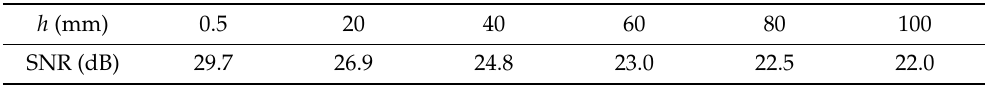
Table 1. Signal to noise ratio SNR calculated for measurements obtained by MO sensor for different concrete cover thicknesses h